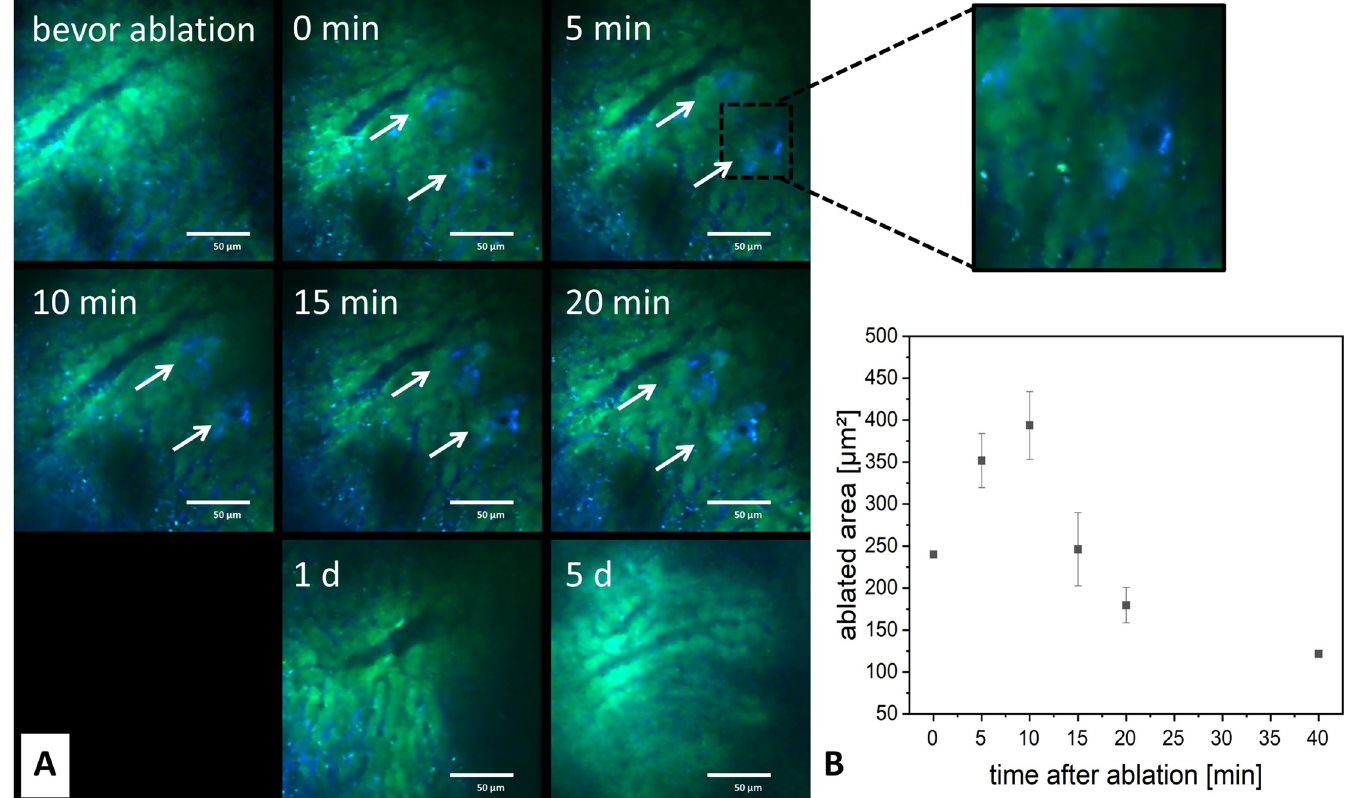
Fig 5. In vivo ablation of single cells in the liver: ( A ) Images acquired before ablation and at various time points after ablation showed fast regeneration of the targeted tissue. ( B ) The ablated area first expanded and later receded again.